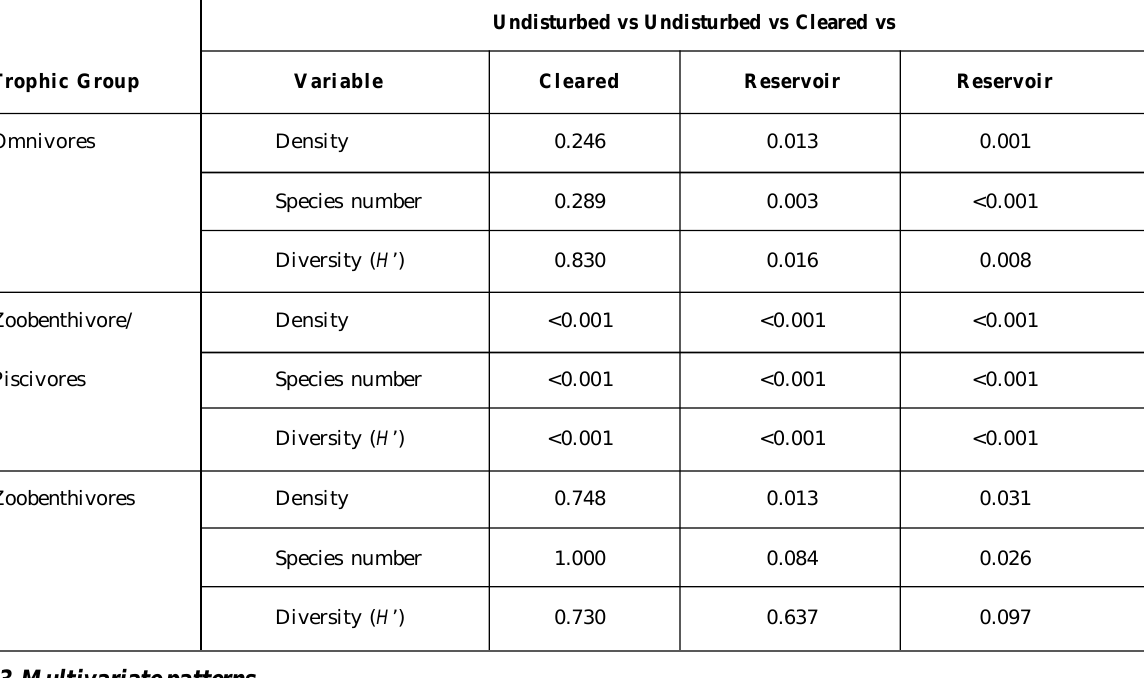
Table 3: Results of Post hoc comparison tests of density, species number and diversity of trophic groups among sites subject to different human activities in mangrove creeks